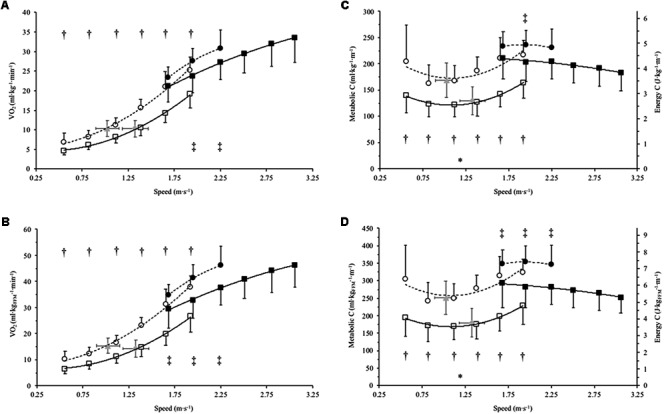
Mean SD (error bars) of net oxygen consumption (V͘O2) and metabolic cost (C) for Achondroplasia (◦) and control (□) when walking (open) and running (closed) at absolute and SSW speeds (m⋅s-1); SSW are presented for Achondroplasia () and control () respectively. V͘O2 and C are presented relative to total body bass (A and C, respectively) and relative to fat free mass (B and D, respectively); C is also presented as the energy cost by considering 1 ml of O2 = 20.9 J. ∗P < 0.05 at SSW between groups; †P < 0.05 between groups at paired walking speeds; ‡P < 0.05 between groups at paired running speeds. V͘O2 and C and speed relationships are fitted with a 2nd order polynomial, with the broken and continuous lines being the trends for the Achondroplasic and control group, respectively.